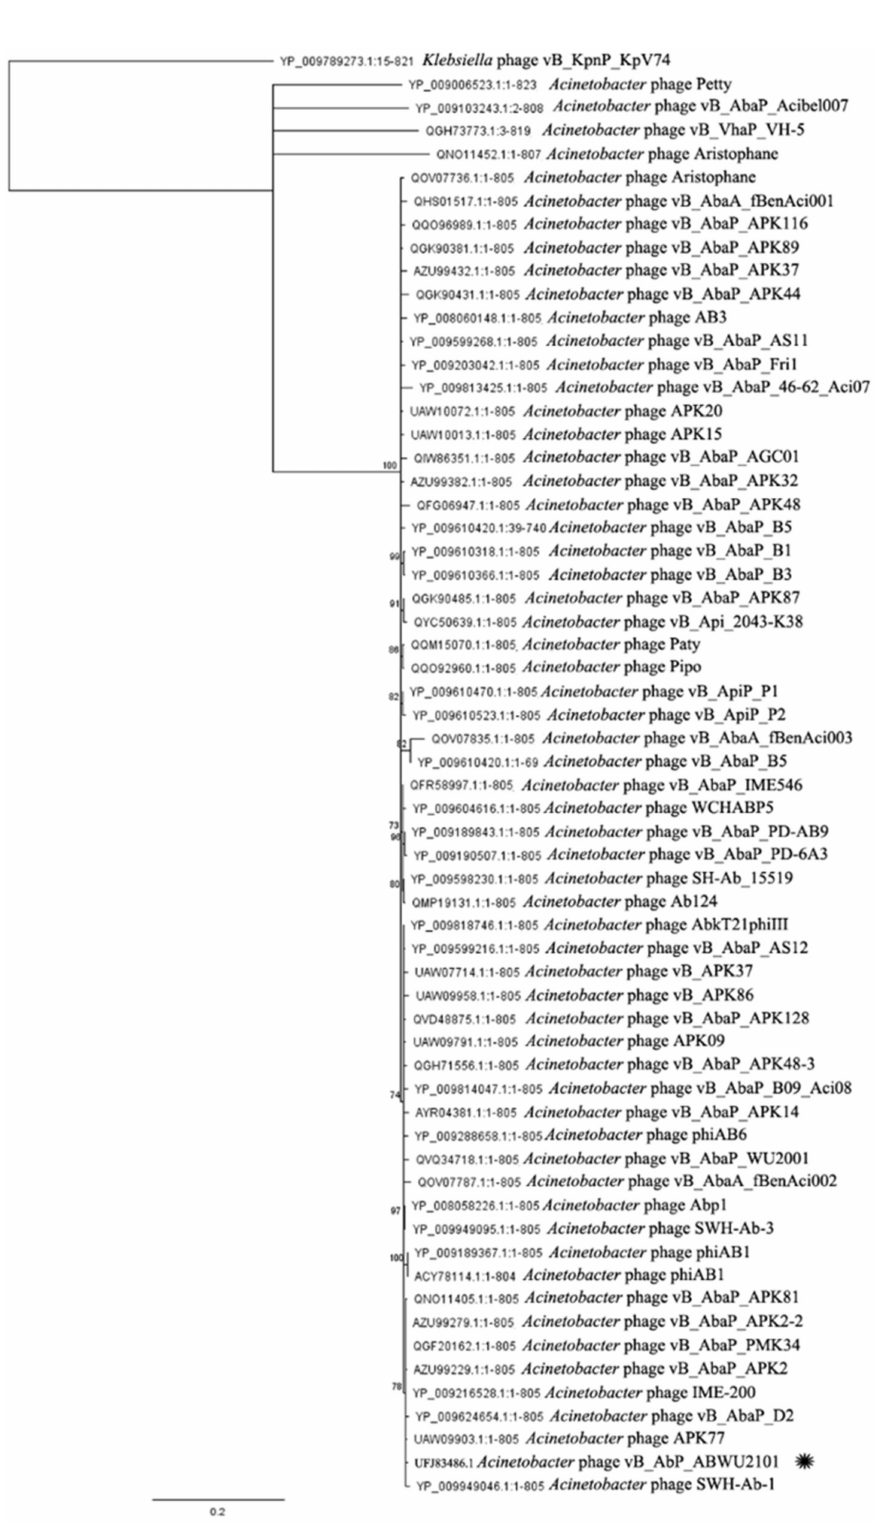
Figure 5. Comparative analysis of phage RNA polymerase proteins. The phylogenetic tree of RNA polymerase proteins was generated by the Geneious server using the neighbor-joining phylogenetic tree based on the JTT model with 1000 bootstrap replications. Bootstrap percentages (>70) from the neighbor-joining method are represented at the nodes of the branches (above). The scale bar represents 20% amino acid substitution. The query sequence is marked with an asterisk.